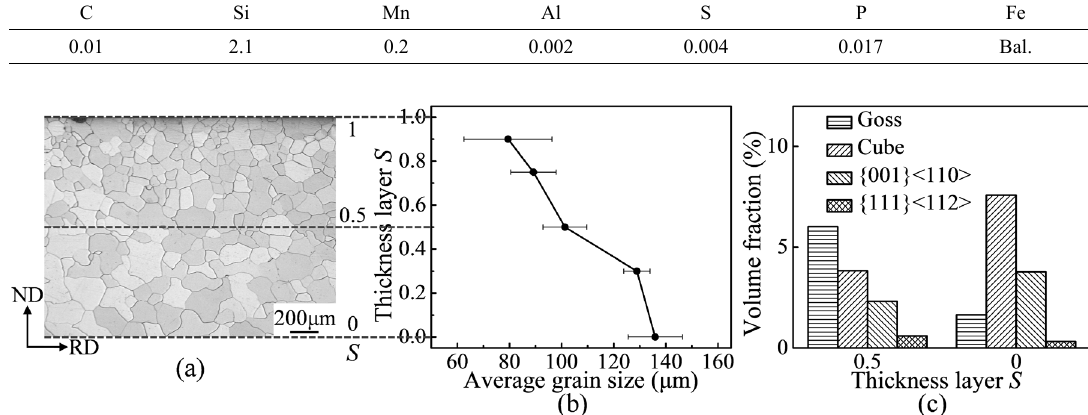
Figure 1. (a) Microstructure, (b) average grain size through the thickness, and (c) volume fraction of main texture components in Fe-2.1 wt.% Si normalized hot